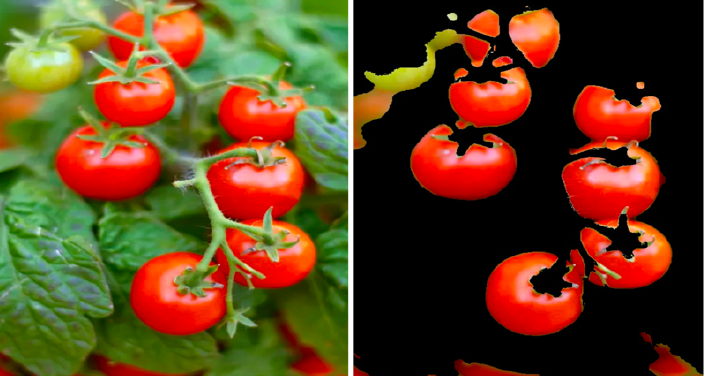
Figure 15. Original image ( left ) and final processed image ( right